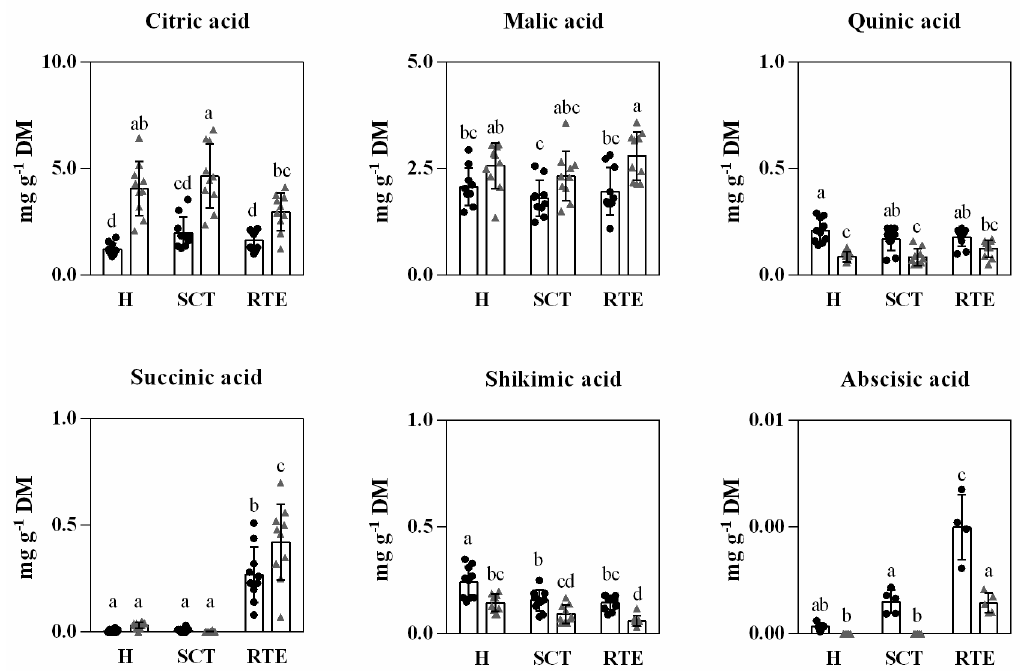
Figure 5. Abundance of main organic acids in Hass avocado from two countries, Spain (black dots) and Chile (gray triangle) at harvest (H), after supply chain type (SCT) and at the ready-to-eat stage (RTE). Each column represents an average of 10 biological replicates and the standard deviation (SD) is represented by bars. Different letters indicate significant differences ( p < 0.05) determined by an ANOVA followed by Tukey test.